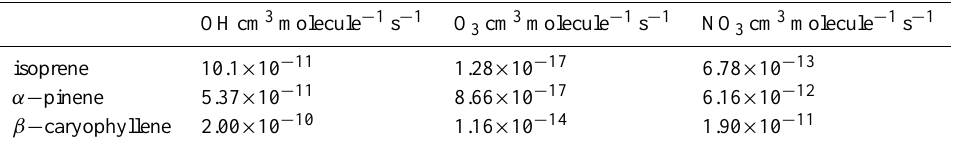
Table 2. Reaction coefficients of isoprene, α -pinene and β -caryophyllene against OH, O 3 and NO 3 . Reaction coefficients for isoprene and α -pinene from Atkinson (1994) and those for β -caryophyllene from Shu and Atkinson (1995).